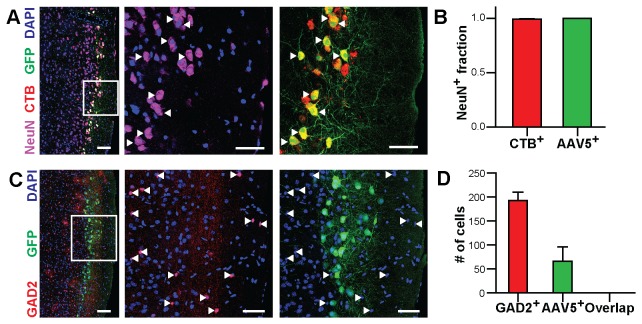
Retrogradely labeled cells in the entorhinal cortex are excitatory neurons.A) Confocal fluorescence images of the same horizontal section of the ventral entorhinal cortex of a mouse that received a co-injection of rAAV5 driving GFP expression (green) and fluorescently labeled CTB (red) that was stained with DAPI (blue) and immunohistochemically labeled against the neuronal marker NeuN (magenta). Examples of individual GFP and CTB-labeled neurons are marked with white arrowheads. The white square denotes the area shown in higher magnification. Scale bars: low magnification: 100 µm, high magnification: 50 µm. B) Quantification of CTB positive cells and GFP positive cells (bars: mean±SEM; CTB: n= 918 cells, 4 sections, one mouse; GFP: n=264 cells, 4 sections, one mouse) with the neuronal marker NeuN showing in both cases almost complete co-labeling. C) Confocal fluorescence images of the same horizontal section of the ventral entorhinal cortex of a transgenic mouse in which GAD2-expressing interneurons are labeled by tdTomato (red) that received an injection of rAAV5 driving GFP expression (green) that was stained with DAPI (blue). Individual interneurons are marked with white arrowheads. The white square denotes the area shown in higher magnification. Scale bars: low magnification: 100 µm and high magnification: 50 µm) D) Quantification of GAD2-expressing interneurons and rAAV5 transduced neurons showing disjunct populations (bars: mean±SEM; n=1033 cells, 4 sections, one mouse).